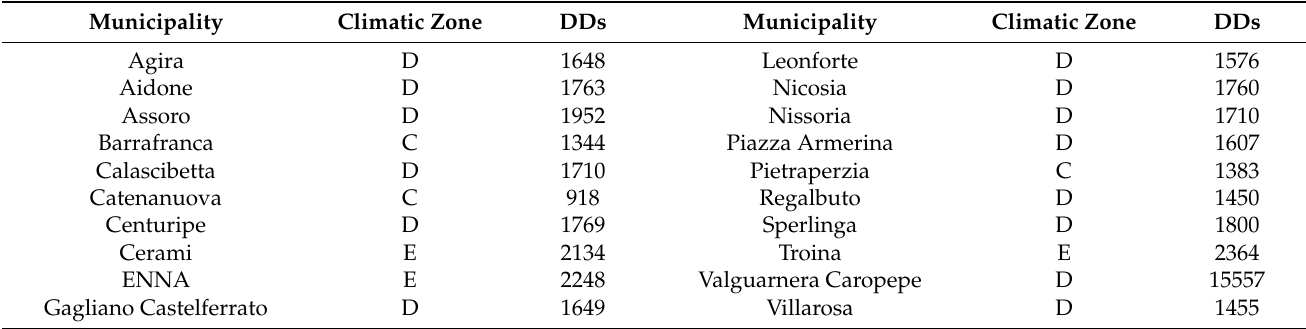
Table 1. Climatic zone distribution in the province of Enna. Personal elaboration using data extrapolated from the Presidential Decree n.412/93 [36].